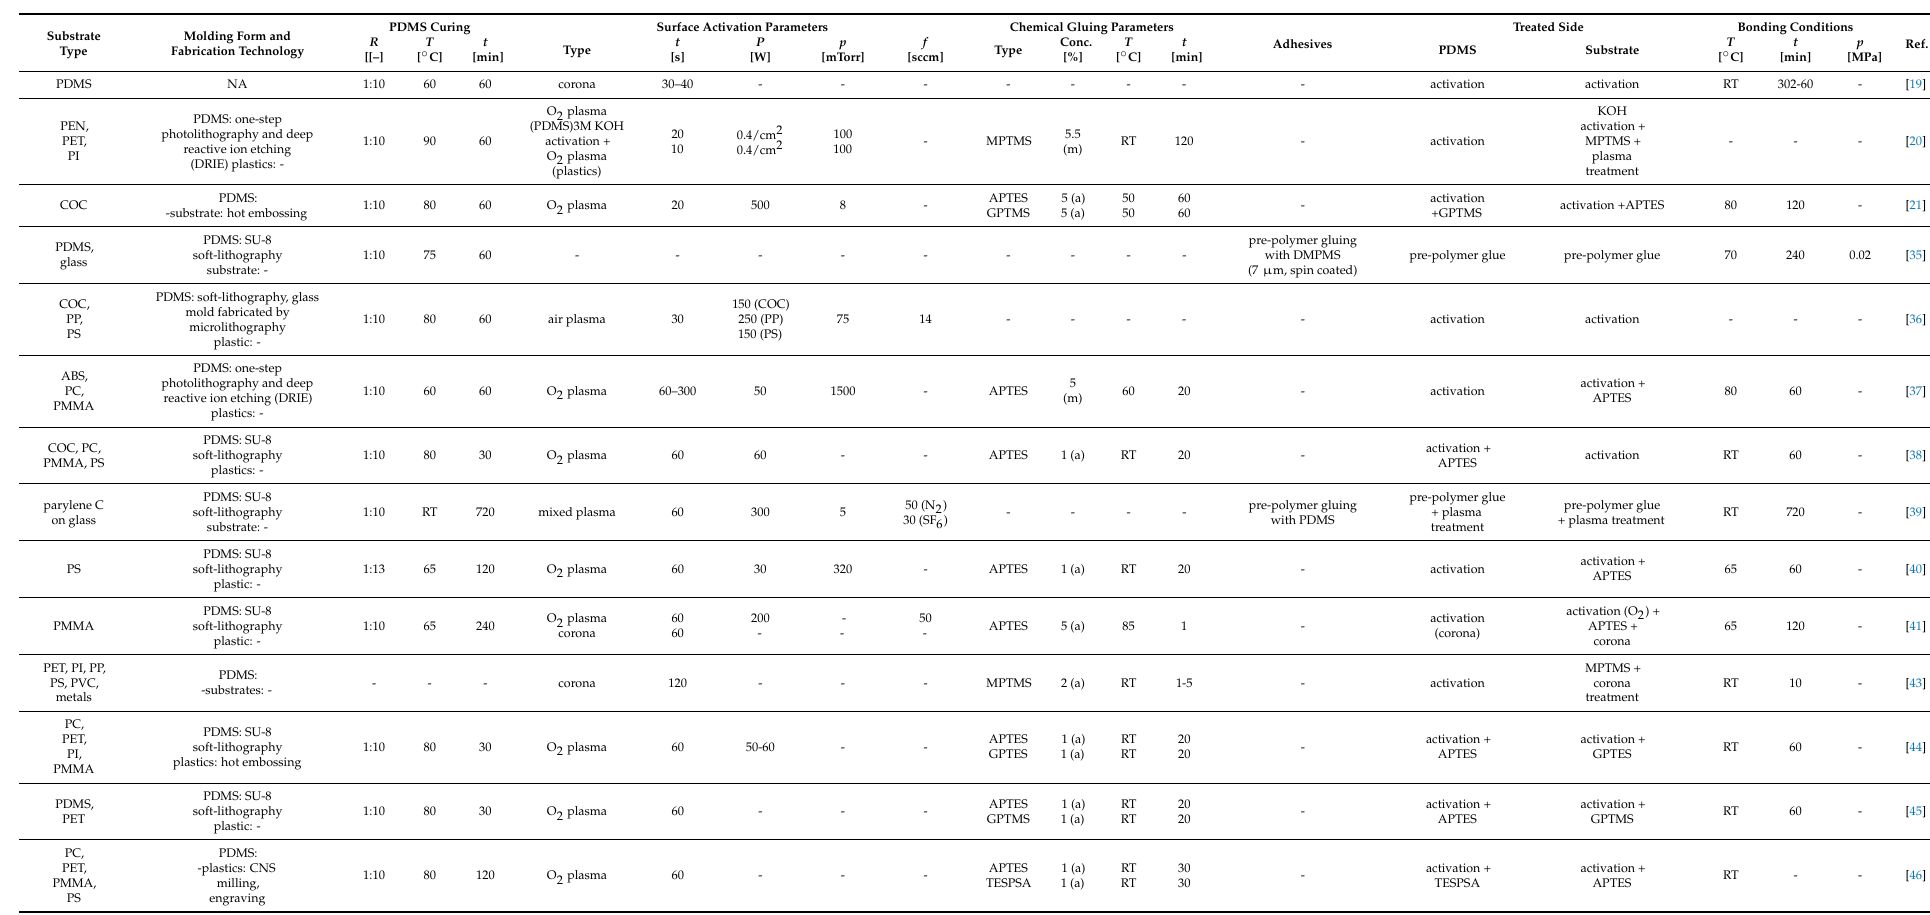
Table 3. Optimized process parameters for bonding PDMS with different substrates. For the bonding strength test results see Table 2. Abbreviations: APTES, 3-aminopropyl)- triethoxysilane; CNC, Computer Numerical Control; COC, Cyclic Olefin Copolymer; DMPMS, Dimethyl-MethylPhenylMethoxy Siloxane; DRIE, Deep Reactive Ion Etching; GPTES, 3-glycidyloxypropyl)triethoxysilane; GPTMS, 3-glycidyloxypropyl)trimethoxysilane; KOH, Potassium hydroxide; MPTMS, 3-mercaptopropyl)trimethoxysilane; NOA74, Norland Optical Adhesive; PC, Polycarbonate; PDMS, Polydimethylsiloxane; PEN, Polyethylene Naphthalate; PET, Polyethylene Terephthalate; PI, Polyimide; PMMA, Poly(methyl methacrylate); PS, Polystyrene; PVC, Polyvinyl Chloride; RT, Room Temperature; TESPSA, 3-triethoxysilyl)propylsuccinic anhydride; UV, Ultraviolet; Physical quantities: R–PDMS curing agent/base polymer ratio, t—time, P—RF plasma power, p—pressure, f—gas flow rate. Conc.—concentration. The label in the bracket refers to the used medium as a—aqueous, e—ethanol,